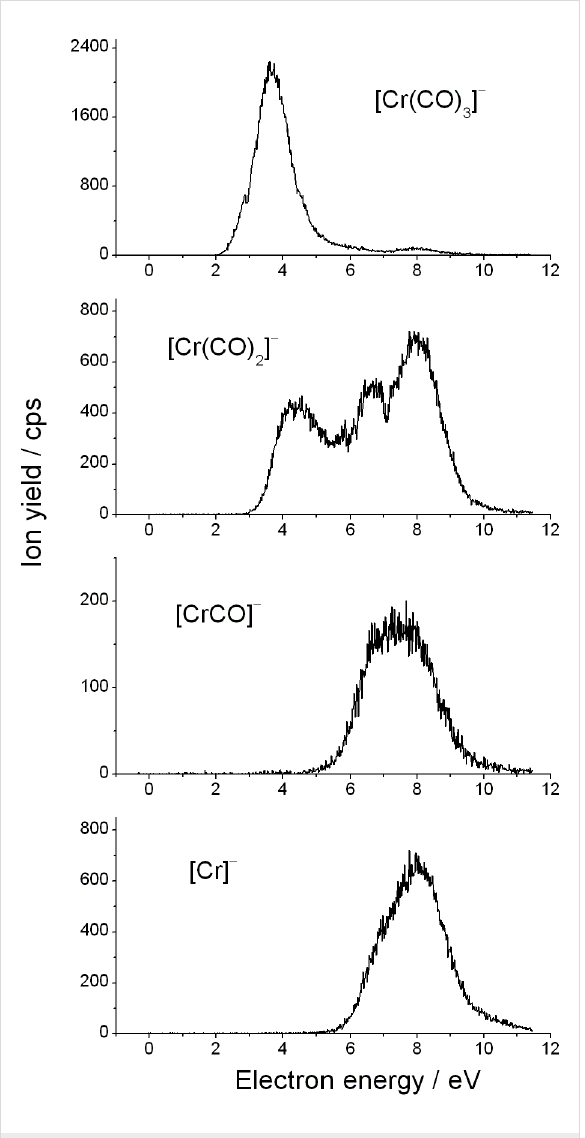
Figure 4: Yield of the fragment anions [Cr(CO) 3 ] − , [Cr(CO) 2 ] − , [CrCO] − , and Cr − obtained from DEA to benzene-chromium(0) tricar-